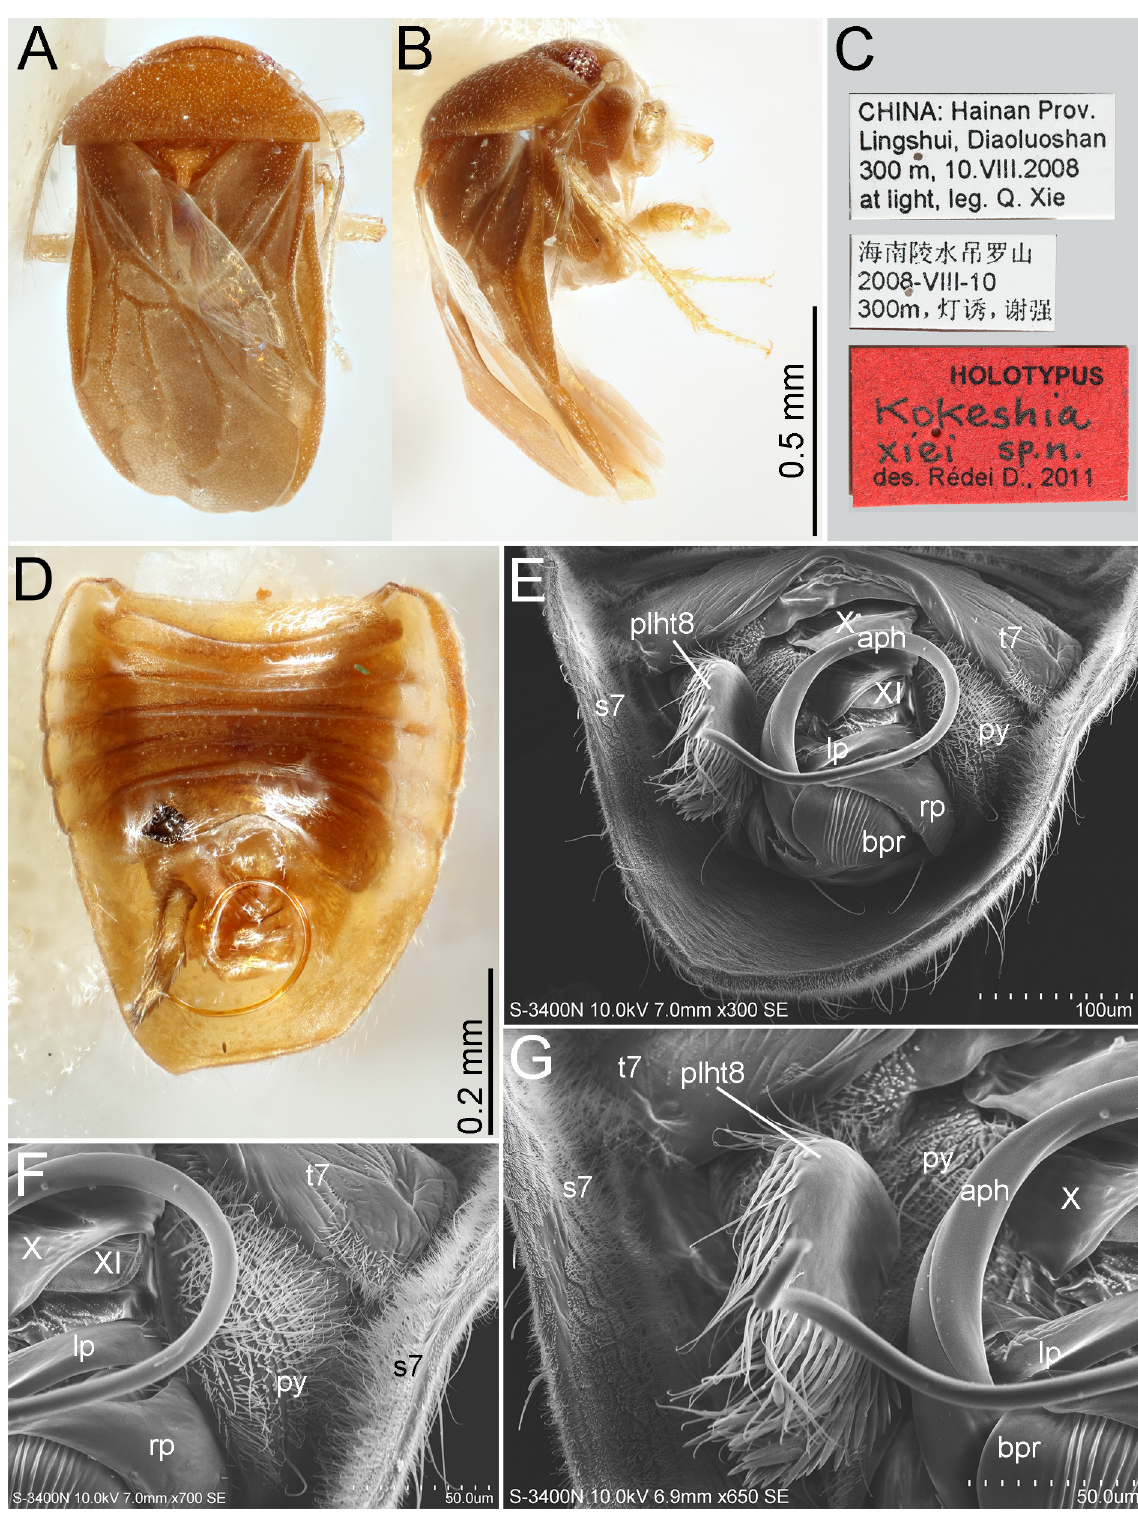
Fig. 23. Kokeshia xiei Rédei, Ren & Bu, 2012. A‒D . Holotype, ♂ (NKUM). A . Dorsal view. B . Lateral view. C . Labels. D . Pregenital abdomen and genitalia, dorsal view. E‒G . Scanning electron micrographs of genitalia, ♂ (SYSBM). E . Dorsal view. F . Right side, dorsal view. G . Left side, dorsal view. Abbreviations: see Material and